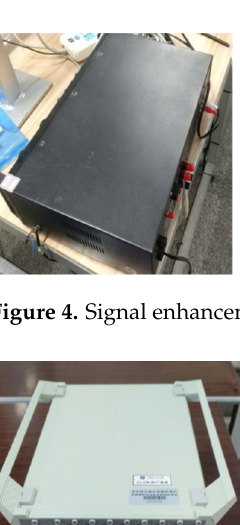
6 of 17 Figure 2. Cylindrical cavity fluid-solid coupling experimental platform. Figure 3. Experimental constraint spring. Different acoustic excitation signals were provided by high power loudspeakers and